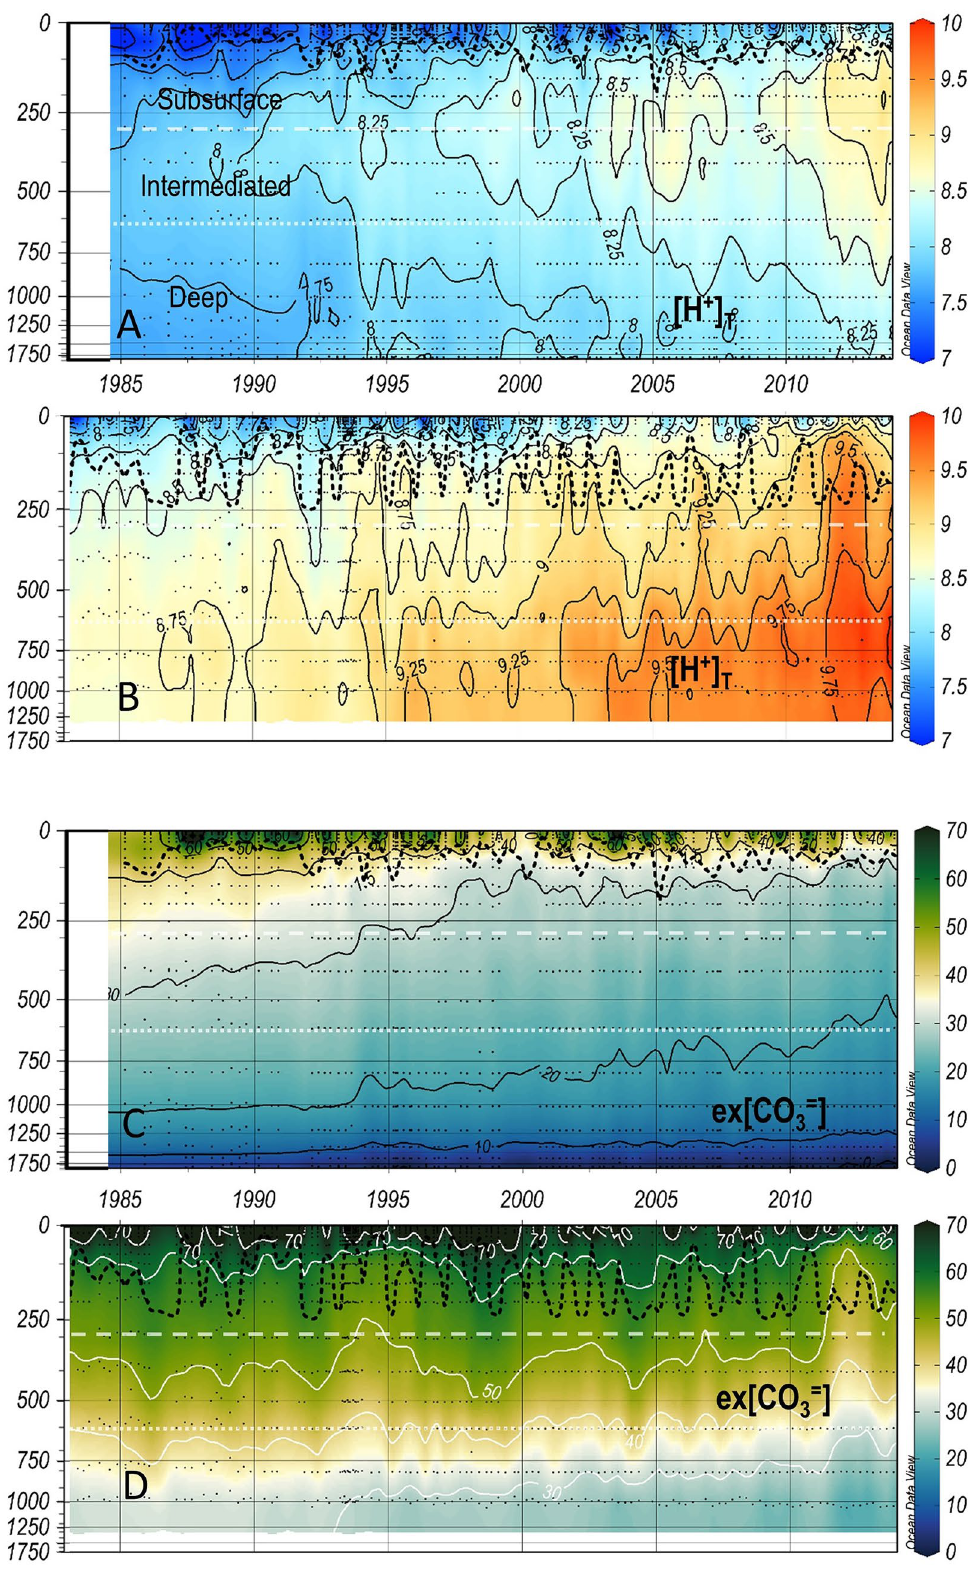
Figure 5. As Fig. 2 for total hydrogen ions concentration in nmol/kg ( [ H + ] T ) and the excess of [CO 3= ] over the [CO 3= ] at aragonite saturation in µmol/kg (ex[CO 3= ]) at IS-TS ( A , C ) and at IRM-TS ( B , D